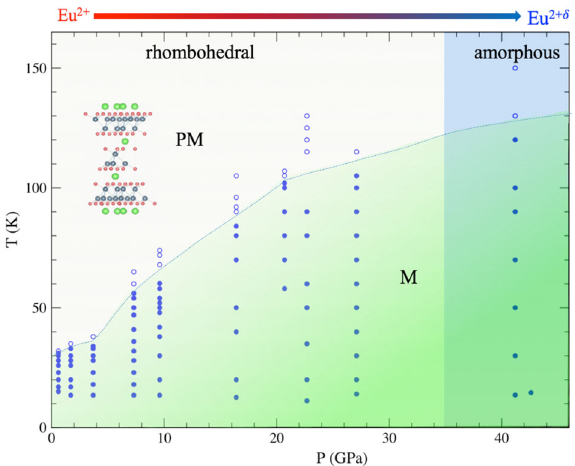
Fig. 8 Schematic phase diagram. P – T phase diagram summarizing the pressure-induced amorphous phase transition above 33 GPa, paramagnetic (PM) to magnetic (M) transition, and pressure-induced valence transition from divalent (Eu 2 + ) to intermediate valence state (Eu 2 + δ ). Solid circles are data points taken in the magnetic phase and open circles are data in the paramagnetic